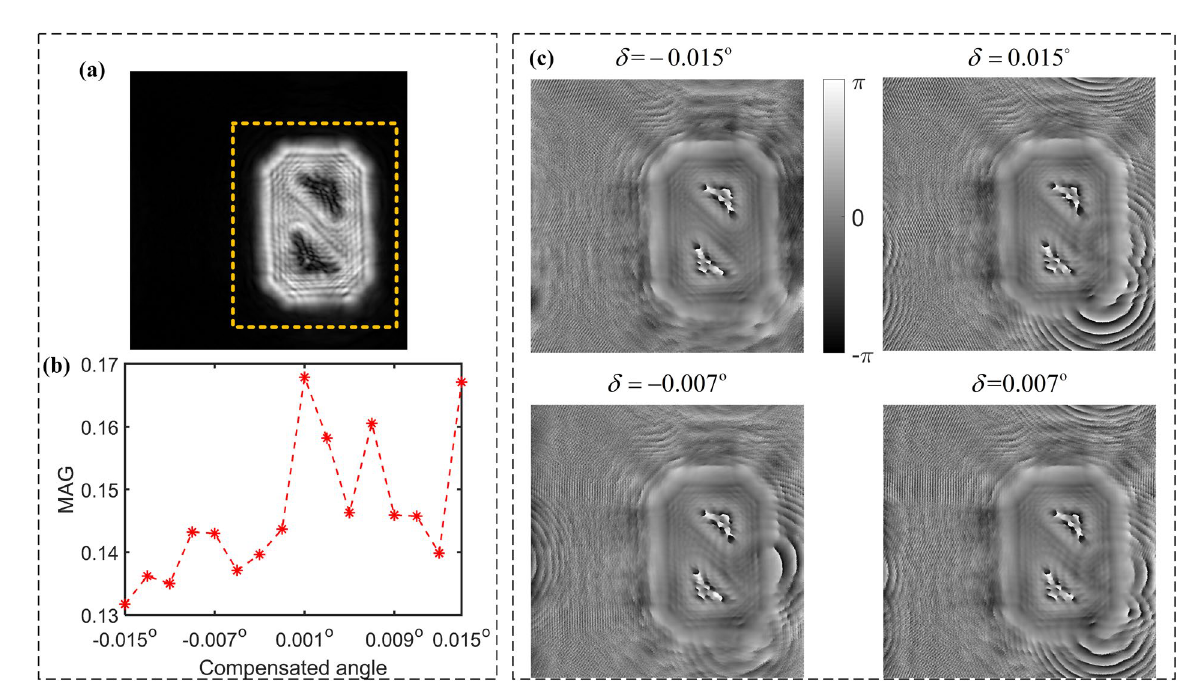
Figure 7. The reconstructed phase with different angle compensation: ( a ) Retrieved amplitude distribution. ( b ) MAG curve, ( c ) Retrieved phase